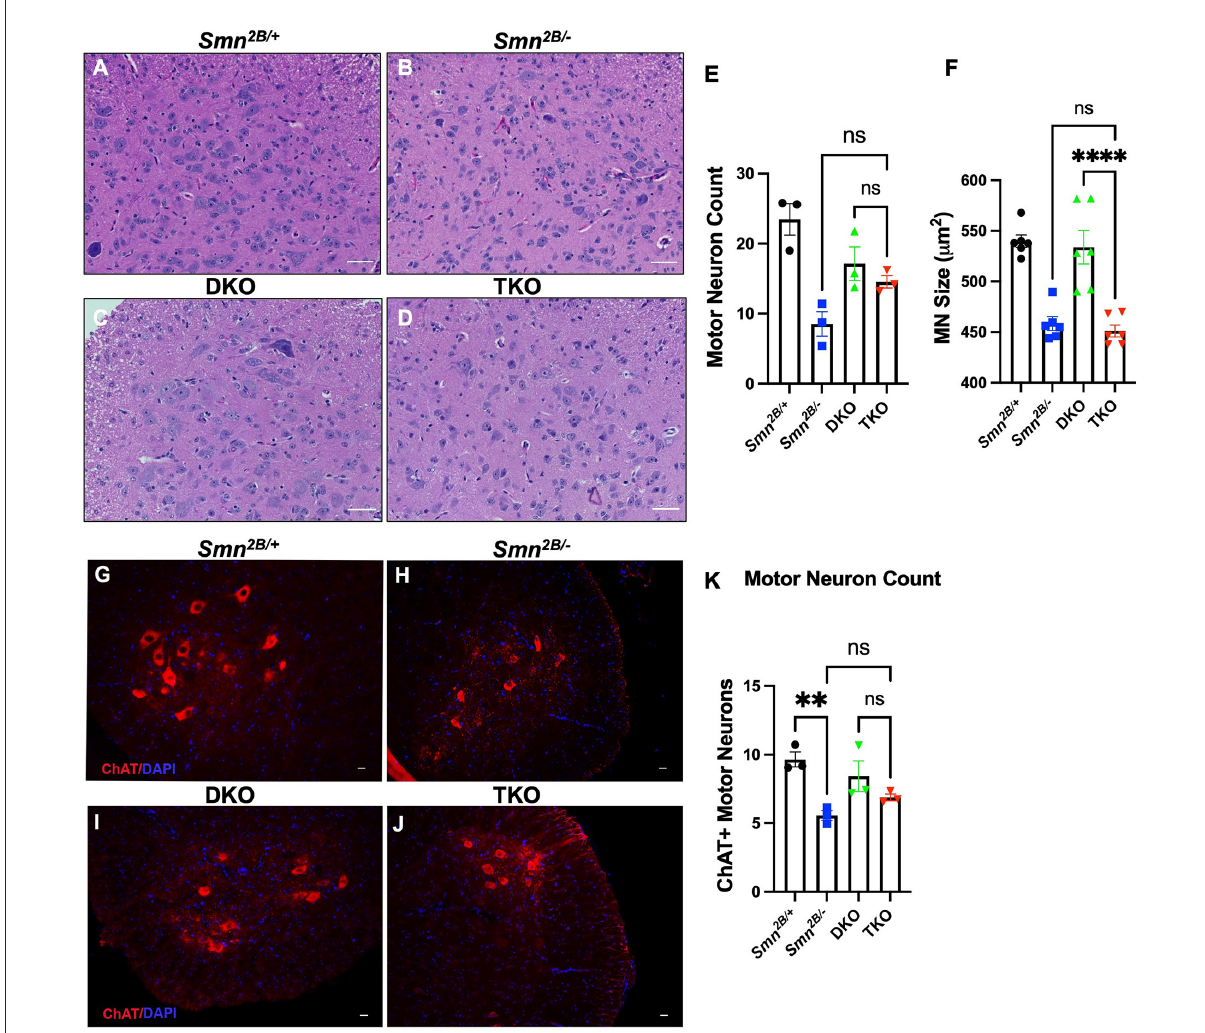
FIGURE4 Genetic ablation of necroptotic cell death pathways does not rescue motor neuron degeneration in Smn 2 B / − mice. (A–D) Representative H&E images (Scale bars = 50 µ m) of sections of lumbar spinal cord from P19 mice and quantification of (E,F) motor neuron cell body number and size, identified by location in the ventral horn, presence of nucleolus, and cells bodies > 350 µ m 2 in cross-sectional area. (G–J) Representative immunofluorescent images of lumbar spinal cord anterior horns stained for ChAT (red) and DAPI (blue) from P19 mice (Scale bars = 20 µ m). (K) Quantification of ChAT positive motor neuron cell body number. The n value for each study is as follows; (A–F) η = 6 − 9 per genotype, (G–K) η = 3 per genotype. Note that a total of 5 sections separated by 10 sections each per animal from the H&E-stained lumbar spinal cord were analyzed for (A–F) and 4 sections separated by at least 100 µ m per animal for (G–K) . Data represent mean ± SEM. An ordinary one-way ANOVA with Tukey post-hoc test for multiple comparison. ns, non-significant. P < 0.001 for ** , and P < 0.0001 for ****